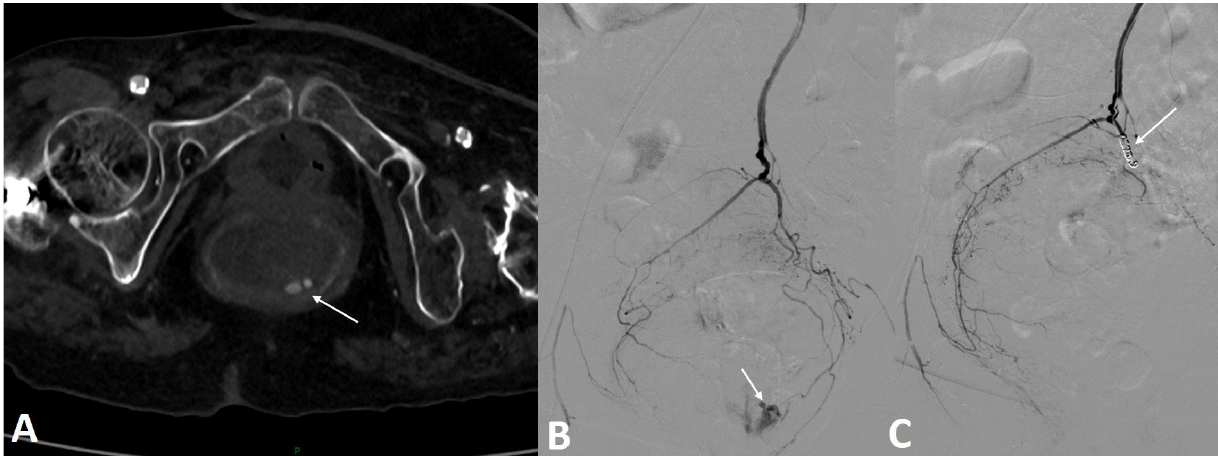
Figure 3. A 73-year-old patient on anticoagulation was referred for profuse rectal bleeding. Colonoscopy failed to stop the bleeding. ( A ) Axial section CT scan injected at arterial time confirming the active contrast extravasation in the rectal lumen. ( B ) Arteriography of the inferior mesenteric artery confirmed the presence of active bleeding from the left superior rectal artery. ( C ) Embolization with three fibered coils allowed a complete stop of the